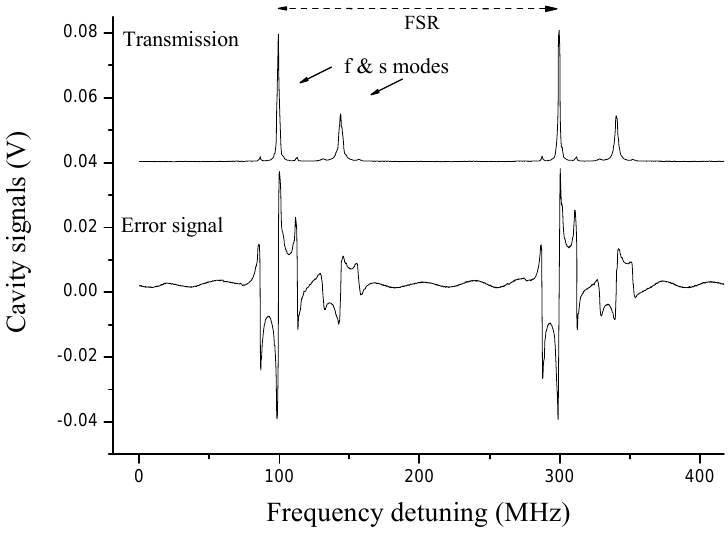
Figure 10. Narrow laser frequency scan equivalent to about one cavity free spectral range (FSR) with RF sidebands at 12 MHz (upper graph). Two peaks appear well separated in frequency by 50 MHz. The PDH signals are also recorded for both polarization eigenmodes.